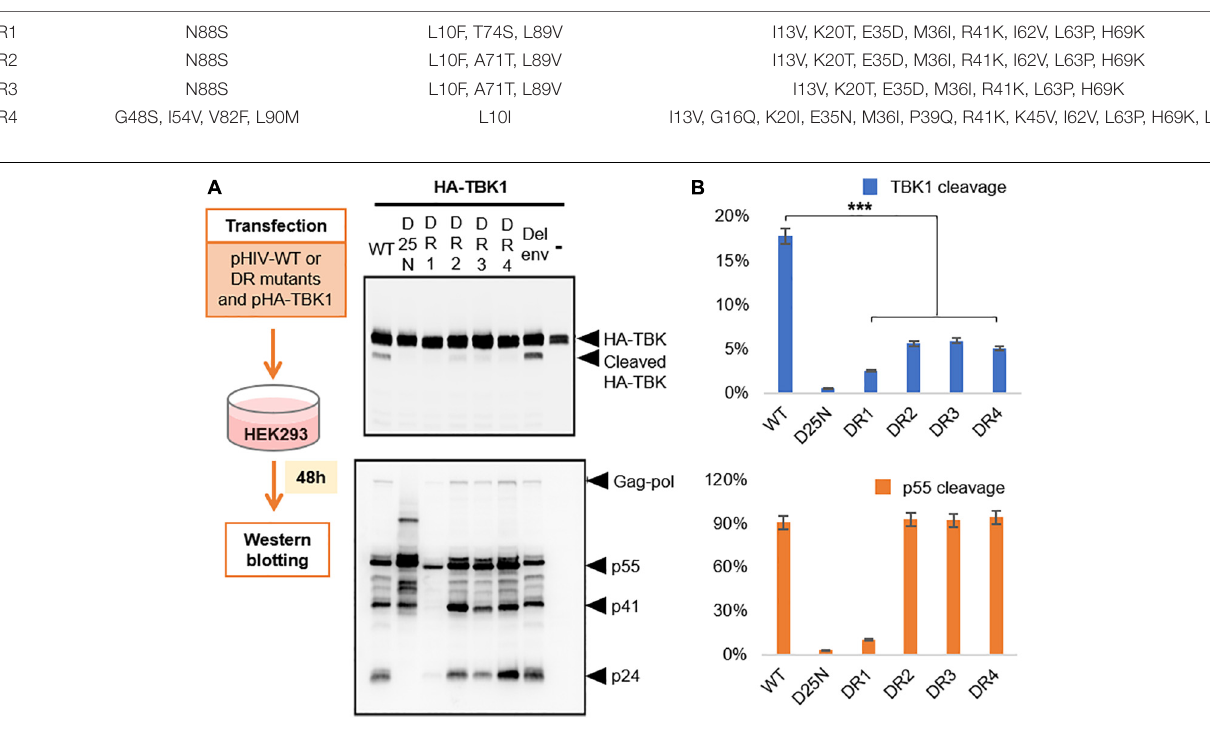
TABLE 1 | HIV-1 protease mutants resistant to protease inhibitors. Clone Major resistance mutations